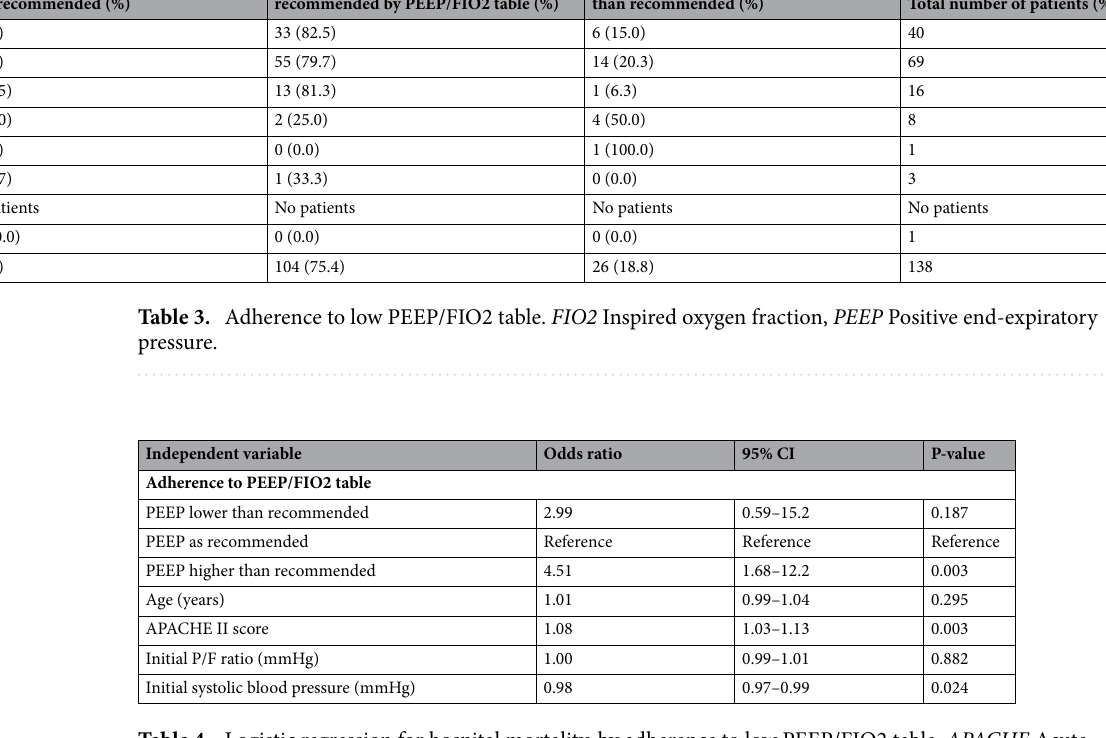
Number of patients with PEEP as recommended by PEEP/FIO2 table (%)